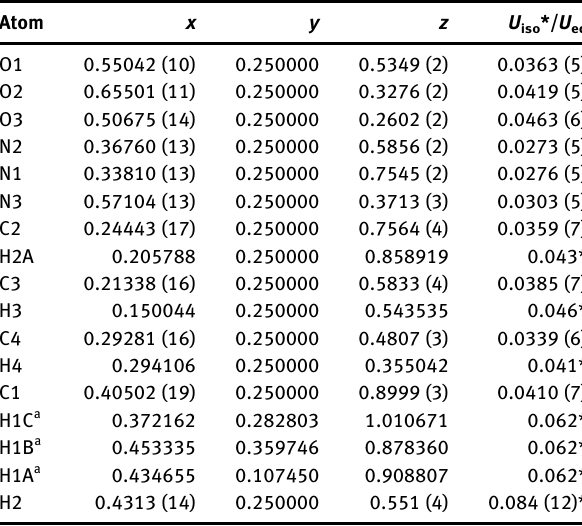
Table  : Fractional atomic coordinates and isotropic or equivalent isotropic displacement parameters (Å 